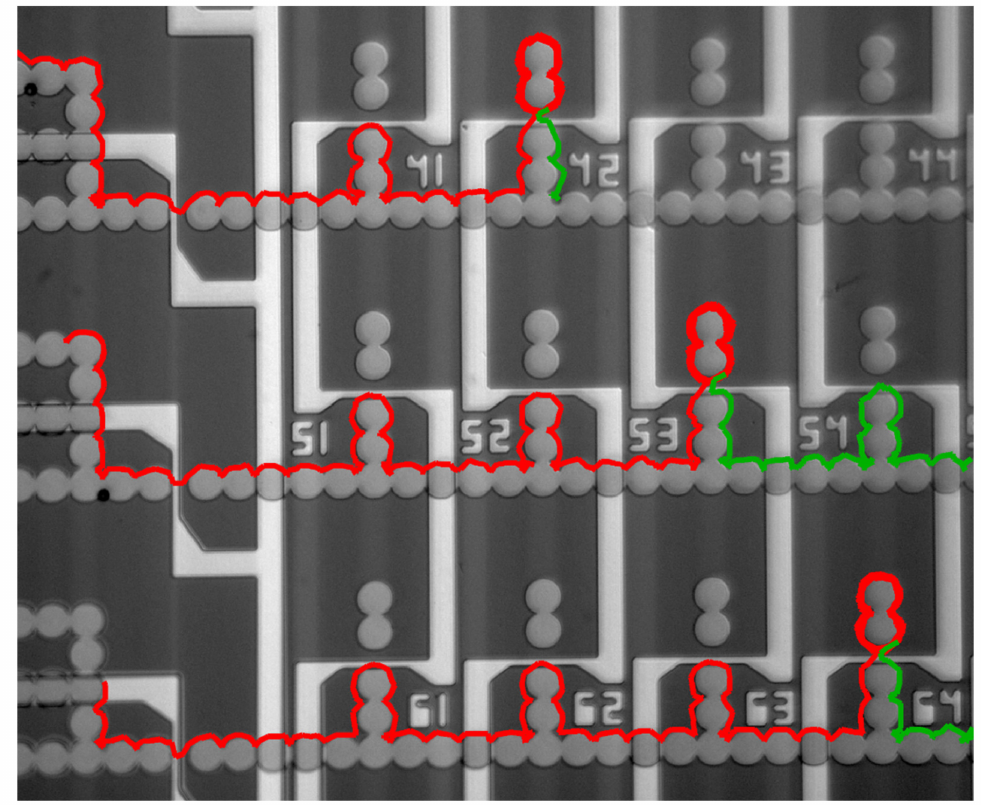
Figure 10. A small section of a magnetophoretic-based circuit designed and built for importing, storing, and exporting magnetic particles and magnetically labeled cells is shown. Here, three magnetic particles are temporarily stored in addressable sites 42, 53, and 64 (trajectories shown in red). At later times, the particles are exported from the chip (trajectories shown in green). Reprinted with permission from R. Abedini-Nassab, et al., 2015 Advanced Materials 27, 6176–6180 [105]. Copyright 2015 John Wiley and